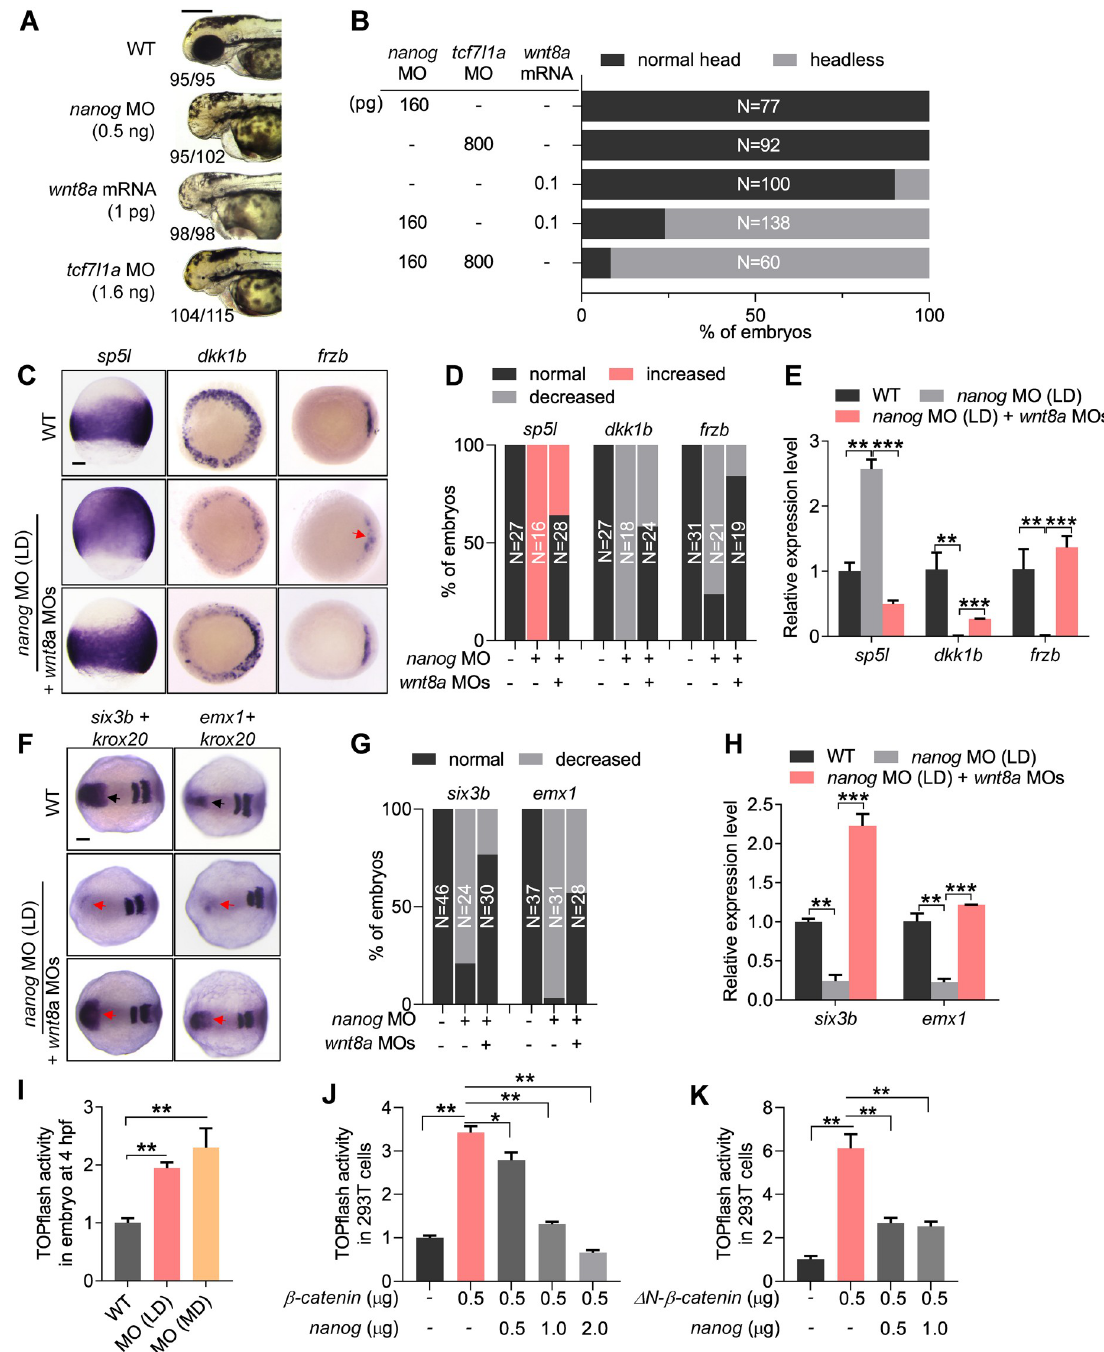
Fig 3. Nanog negatively regulates Wnt/ β -catenin signaling. (A) The embryos injected with LD nanog MO (0.5 ng) exhibit the similar phenotypes—telencephalon defect—with wnt8a mRNA (1 pg per embryo) overexpressed embryos or tcf7l1a MO (1.6 ng per embryo) knocked down embryos. Phenotype was observed at 72 hpf. The numbers below the morphology pictures mean number of embryos showing representative phenotype/total number of embryos. Scale bar, 500 μ m. (B) Embryos injected with titrated LDs of nanog MO (160 pg), wnt8a mRNA (0.1 pg), or tcf7l1a MO (800 pg) showed no obvious defect, respectively, and co-injection of nanog MO with wnt8a mRNA or tcf7l1a MO at the same doses resulted in forebrain truncation (headless). N represents analyzed embryo number. (C) WISH analysis showing the expression of zygotic Wnt target genes; sp5l was up-regulated in nanog morphant, whereas Wnt antagonist dkk1b and frzb were reduced, and this expression defect can be restored by knockdown of wnt8a . Scale bar, 100 μ m. (D) Statistical analysis of the embryos in panel C. N represents analyzed embryo number. (E) Relative mRNA levels of sp5l , dkk1b , and frzb in nanog morphants and